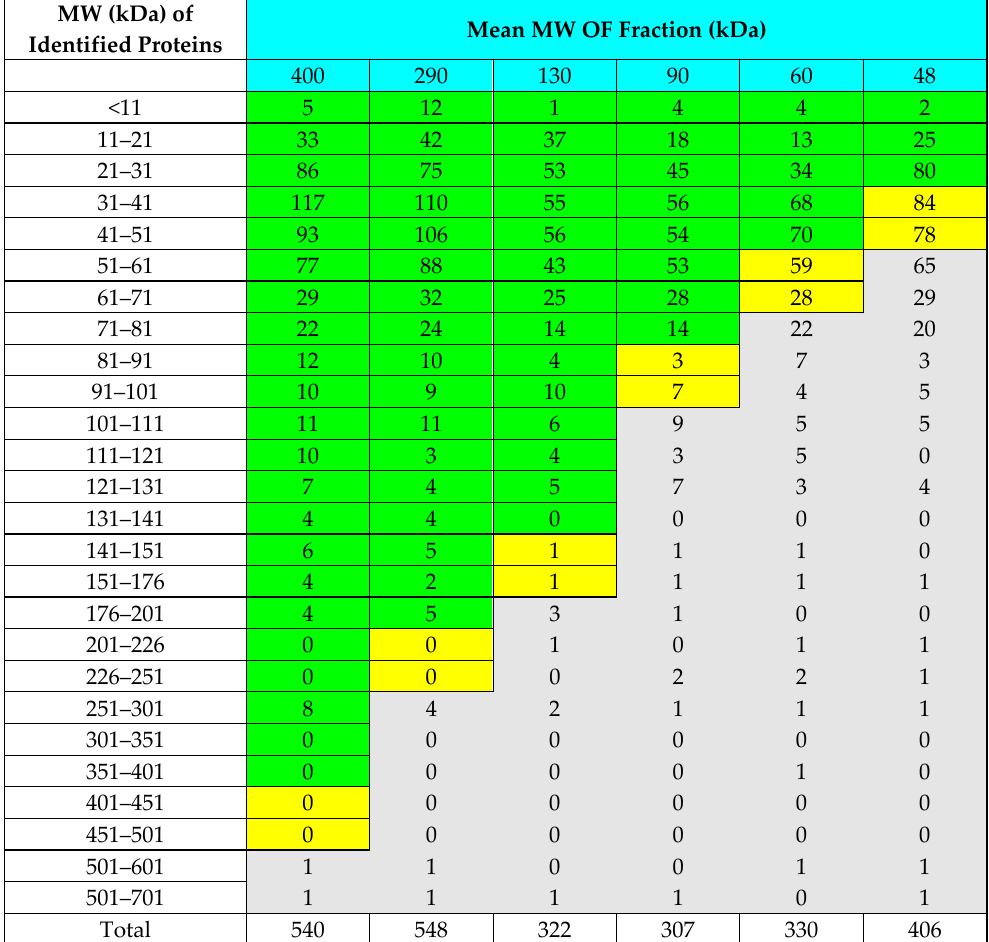
Table 1. A distribution matrix of proteins identified by LC-MS/MS analysis in SEC fractions of liver tissue lysate.